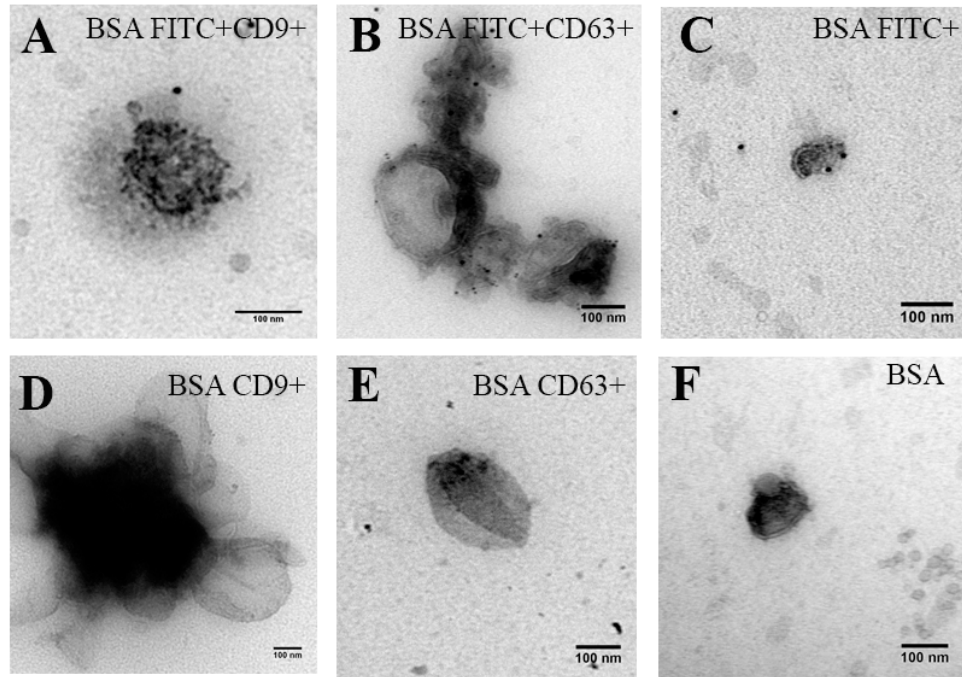
Figure 5. Immunogold electron microscopy of cell supernatant containing EVs derived from HUVEC treated with USMB (0.7 MPa) in the presence of BSA FITC as a model drug. EVs were stained with anti-CD9 or anti-CD63 and the detection antibody was anti mouse IgG secondary antibody labelled with 6-nm gold particles ( A , B ). IgG1 isotype control was used as a control for anti-CD9 and anti-CD63 staining ( C ). Anti FITC secondary antibody labelled with 10-nm gold particles stained BSA FITC present on EVS ( A – C ). As controls, cell supernatant containing EVs with non-conjugated BSA processed and stained in the same manner ( D – F ).